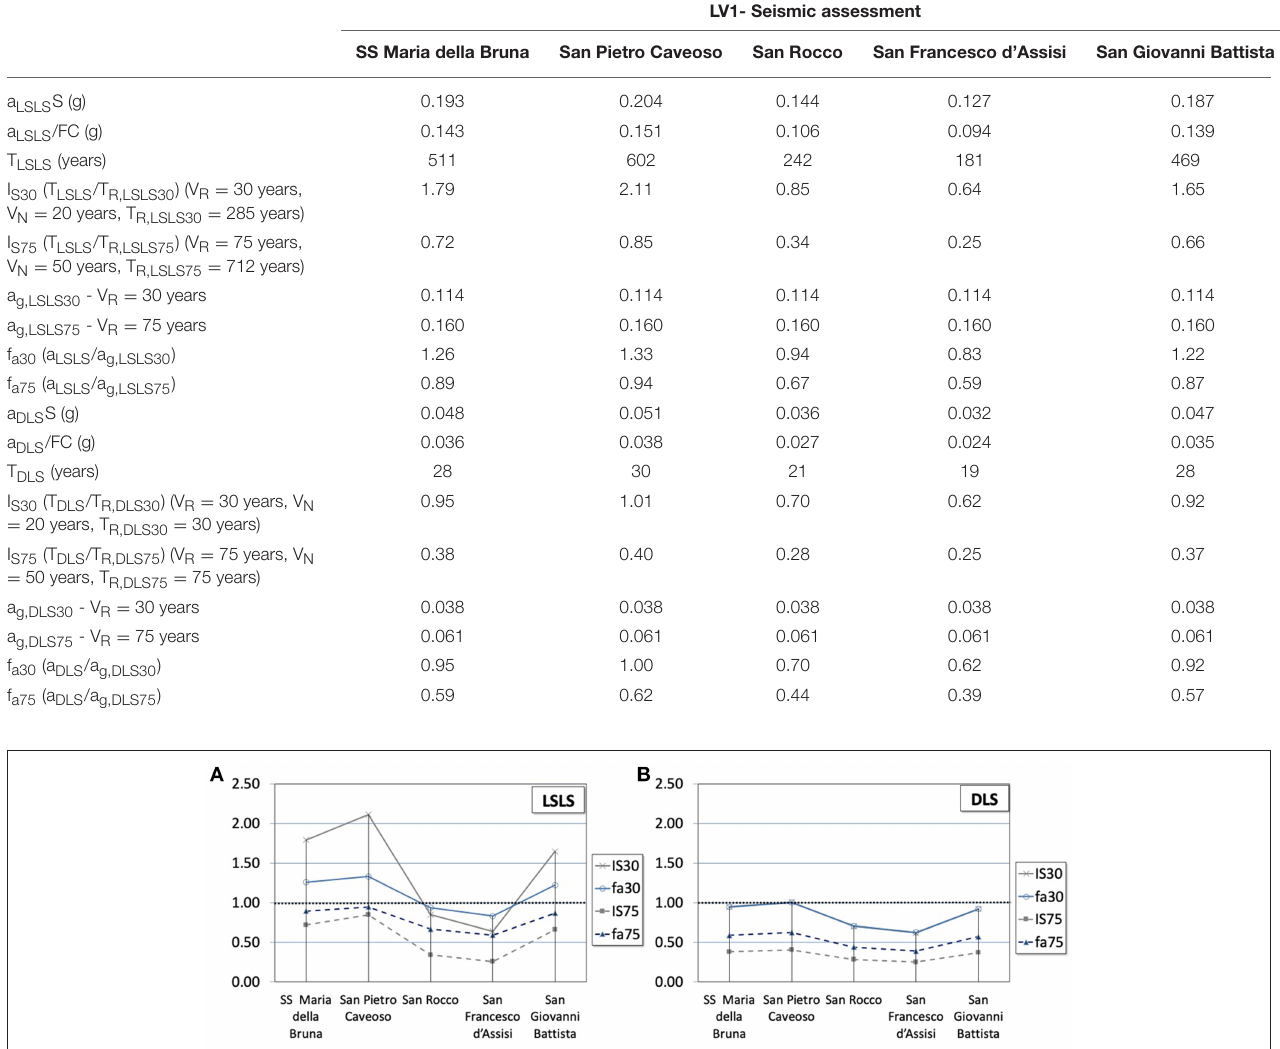
TABLE 3 | Seismic assessment according to the LV1 method for LSLS and DLS.